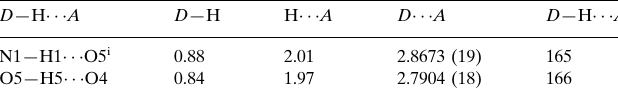
Hydrogen-bond geometry (A˚ , (cid:2)